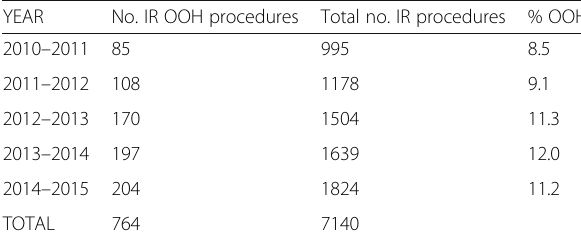
Table 2 Number of out-of-hour compared to total number of IR procedures performed in the unit